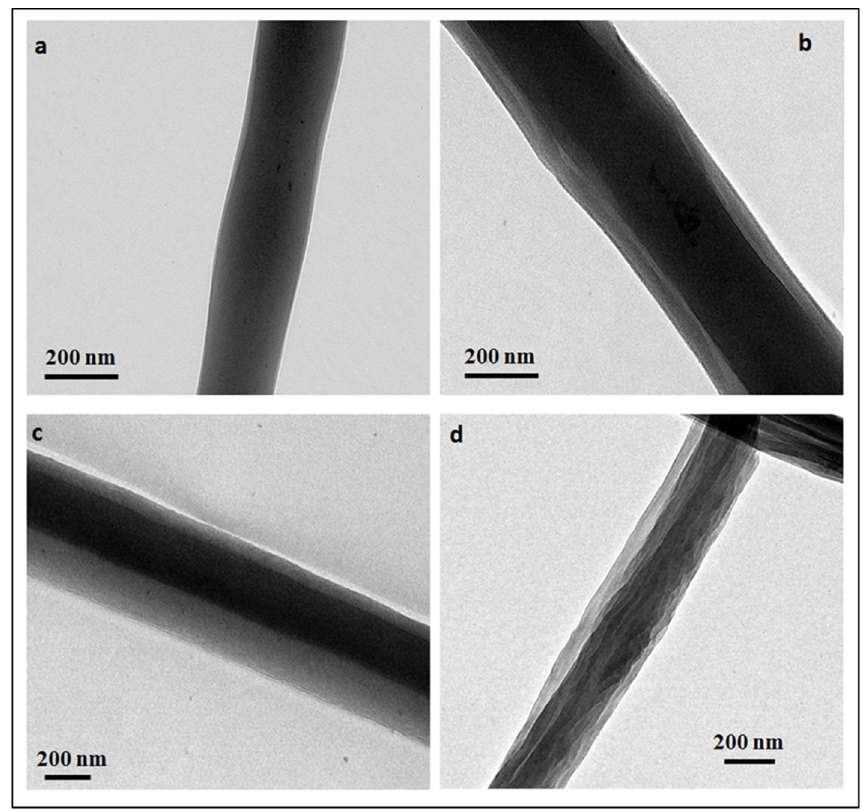
Figure 3. TEM images of core-sheath nanofibers ( a ) CS1, ( b ) CS2, ( c ) CS3, ( d ) CS4. Table 2. Values of core diameters and sheath thicknesses of core-sheath nanofibers with correspond- ing electrospinning flow rates.